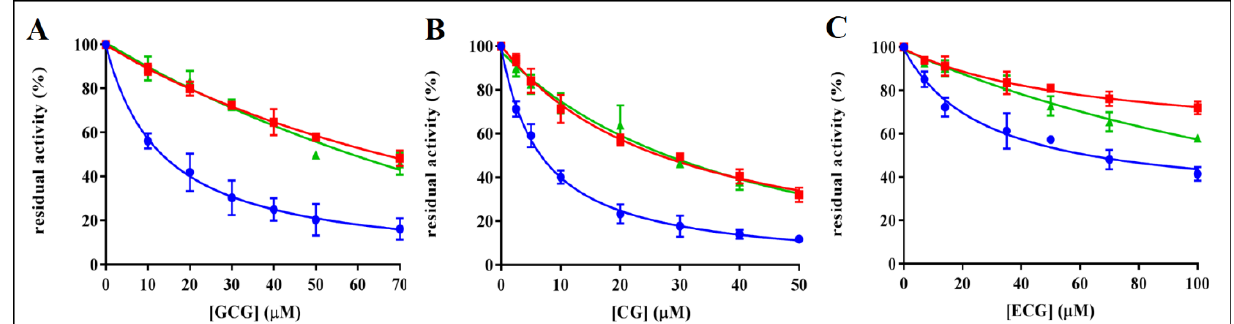
Figure 2. Inhibition curves of AKR1B1 by gallocatechin gallate (GCG), catechin gallate (CG), and epicatechin gallate (ECG). Panel ( A – C ) refer to GCG, CG, and ECG, respectively. The dose-dependent inhibitory effect was evaluated using 10 mU of AKR1B1 and 8 mM L -idose (blue circles), 0.03 mM HNE (red squares), or 0.045 mM GSHNE (green triangles) as substrate. Error bars (when not visible are within the symbol size) represent the standard deviation of the mean from three to five independent measurements.